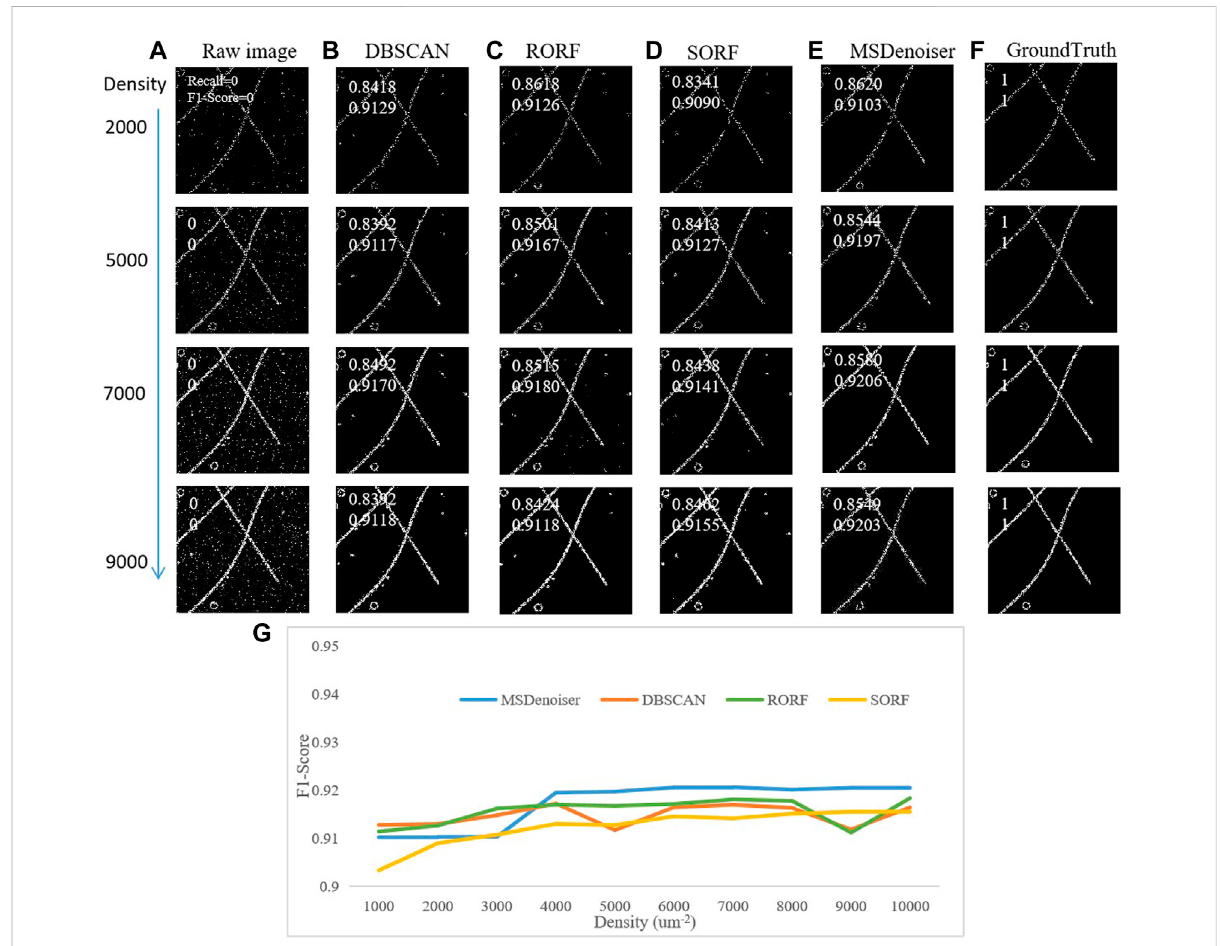
FIGURE 5 Comparison on the denoising performance in simulated patch microtubule data with different localization density by different methods. (A) Rawrenderingimage. (B) DenoisedimagefromDBSCAN. (C) Denoised imagefrom RORF. (D) DenoisedimagefromSORF. (E) Denoisedimagefrom MSDenoiser. (F) Skeleton based groundtruth. (G) The dependence of F1-score on localization